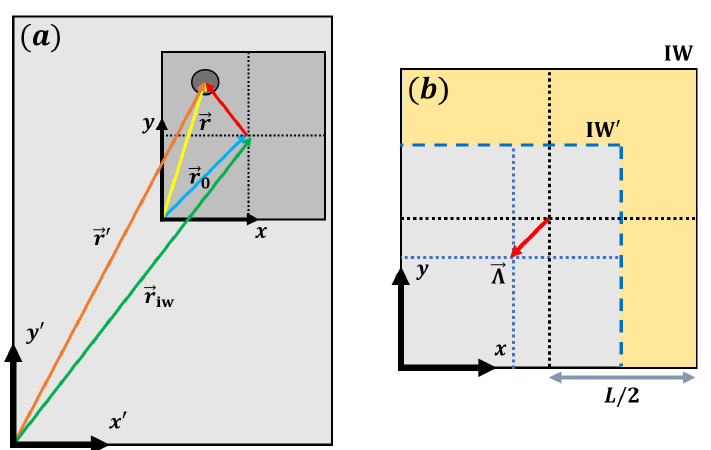
Figure 5. Coordinate mapping from IWs onto the full FOV for objects detected in IWs: ( a ) transfor- mation from the IW coordinate system to the image coordinate system and ( b ) crop correction for the IW center coordinates within the FOV. In ( a ) the circle represents the object detected in the IW (dark gray square). In ( b ) the yellow area indicates the out-of-bounds part of the virtual